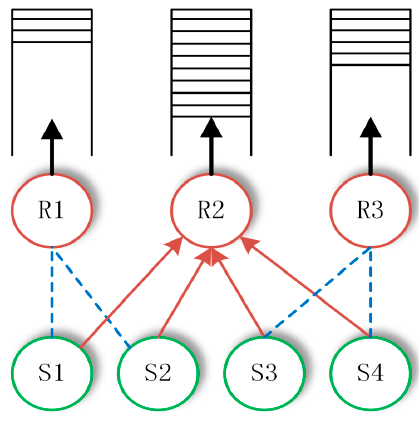
Figure 6. Uneven cache usage.